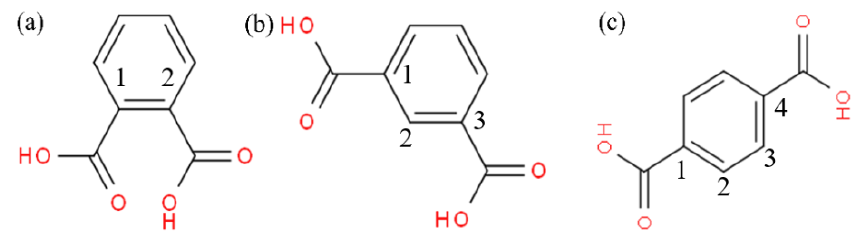
Figure 1. Molecular structural formula of ( a ) PA, ( b ) IPA, and ( c ) TA.